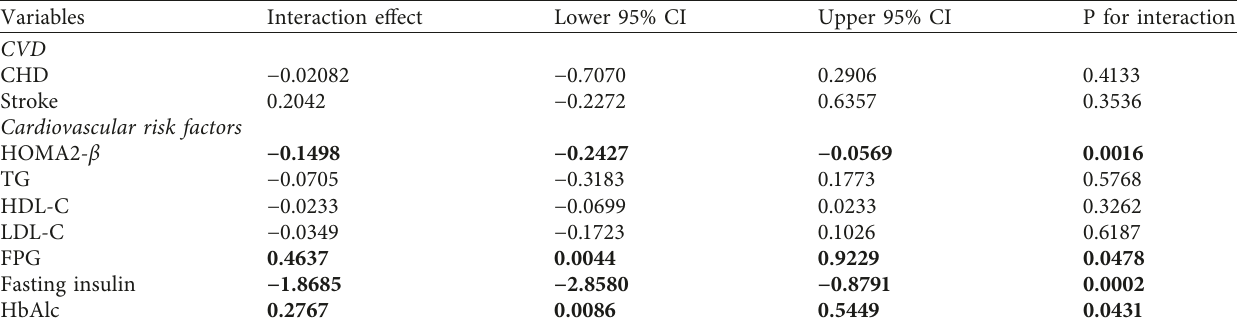
Table 4: Associations between cortisol and cardiovascular risk factors for low, medium, and high levels of 25